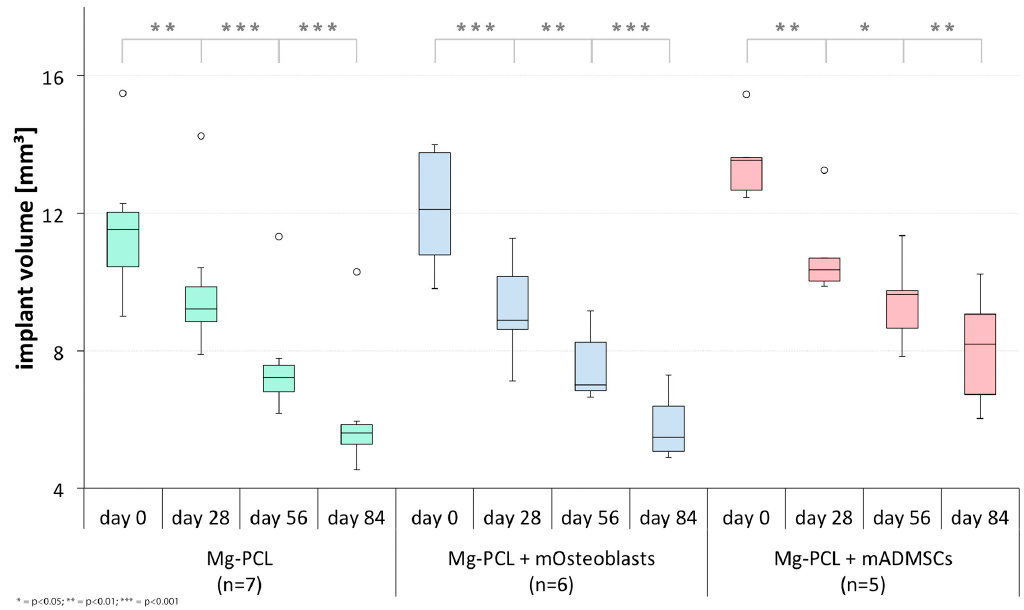
Figure 10. Comparative presentation of the implant degradation between the different measurement times within each magnesium implant-treated group (* = p < 0.05; ** = p < 0.01; *** = p < 0.001; whiskers = minimal and maximal values; horizontal line = median; circles = outliers).